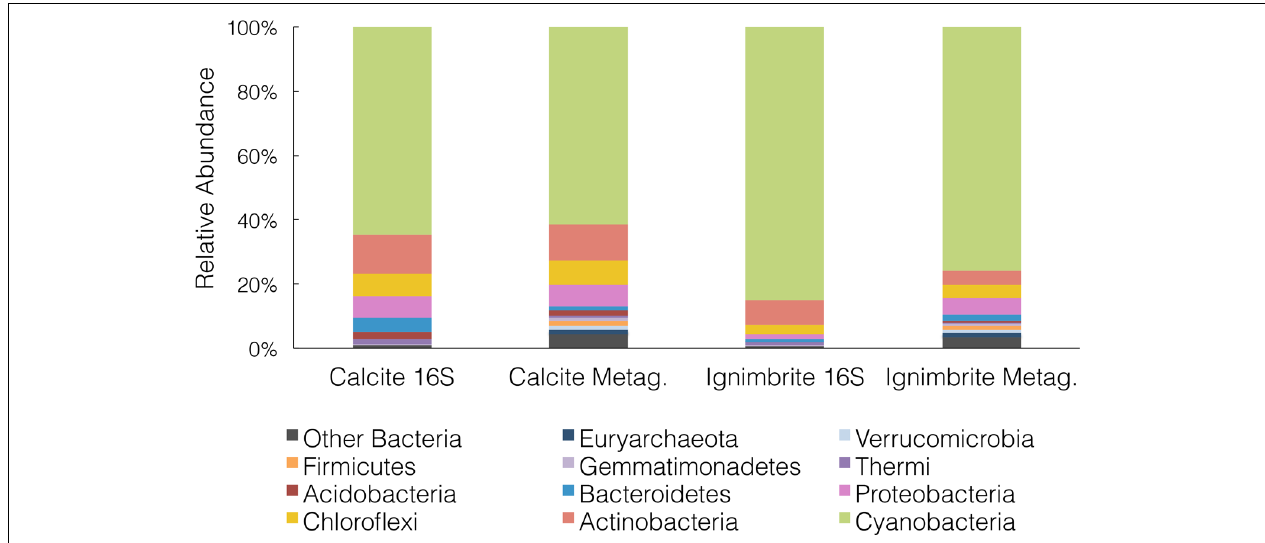
FIGURE 3 | Taxonomic composition at the phylum level for the calcite and ignimbrite communities using either 16S rRNA gene sequences (16S) or PhyloSift marker genes from the metagenome data (Metag) (10% relative abundance cut-off).